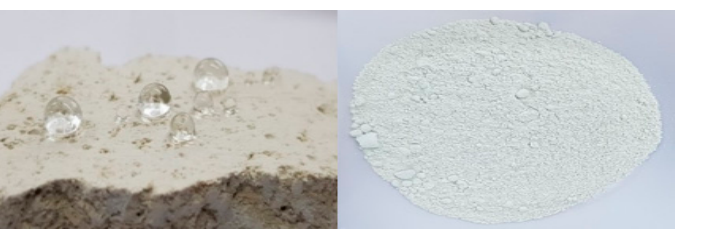
Figure 1. Water-repellent impregnated natural zeolite .